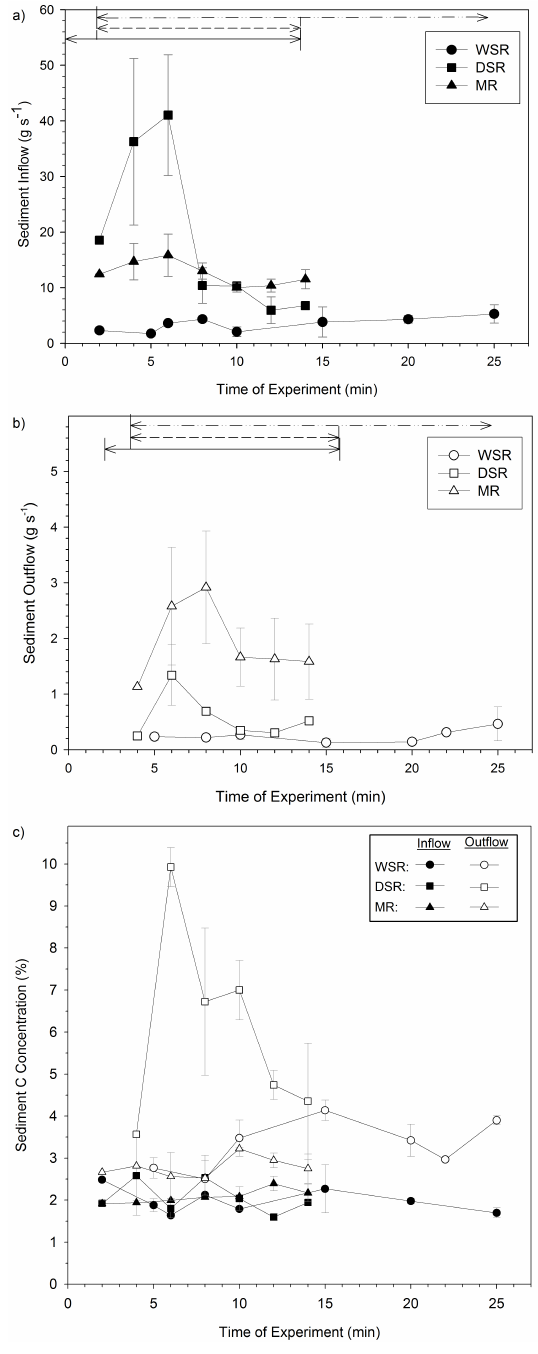
Fig. 3. (a) Sediment inflow (gs − 1 ), defined as sediment discharge measured at the inlet of the depositional area for the three simula- tion experiments (average of replicate runs). (b) Sediment outflow (gs − 1 ), defined as sediment discharge measured at the outlet of the depositional area for the three simulation experiments (average of replicate runs). (c) Sediment carbon concentration (%) in runoff at the inlet (gray) and outlet (white) of the depositional area for the three simulation experiments (average of replicate runs). The arrows mark the duration of runoff for each experiment: WSR (dot- dashed), DSR (dashed), MR (full line). Error bars indicate the stan- dard error of the